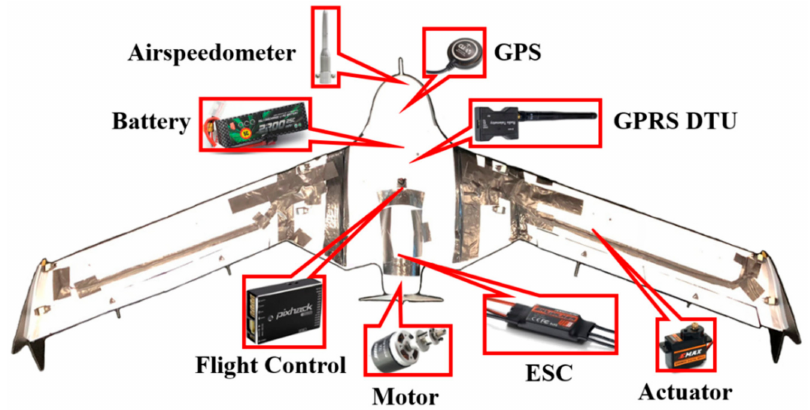
Figure 10. Completed UAV assembly and airborne equipment.